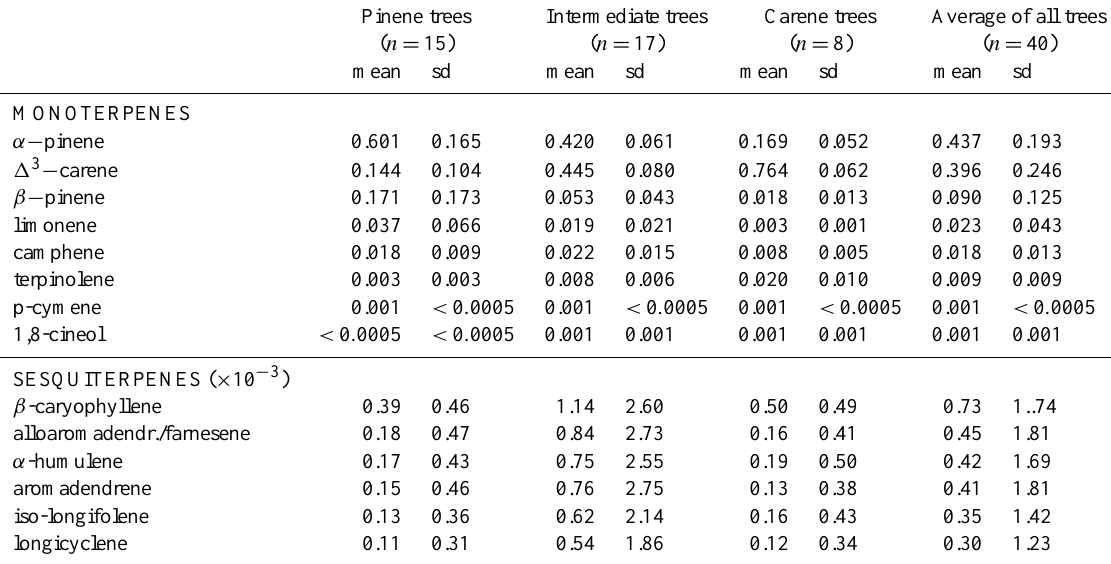
Table 1. Averages and standard deviations (sd) for proportions of monoterpenes and sesquiterpenes in total terpenoid emission, differentiated into chemotype groups, and averaged over the whole